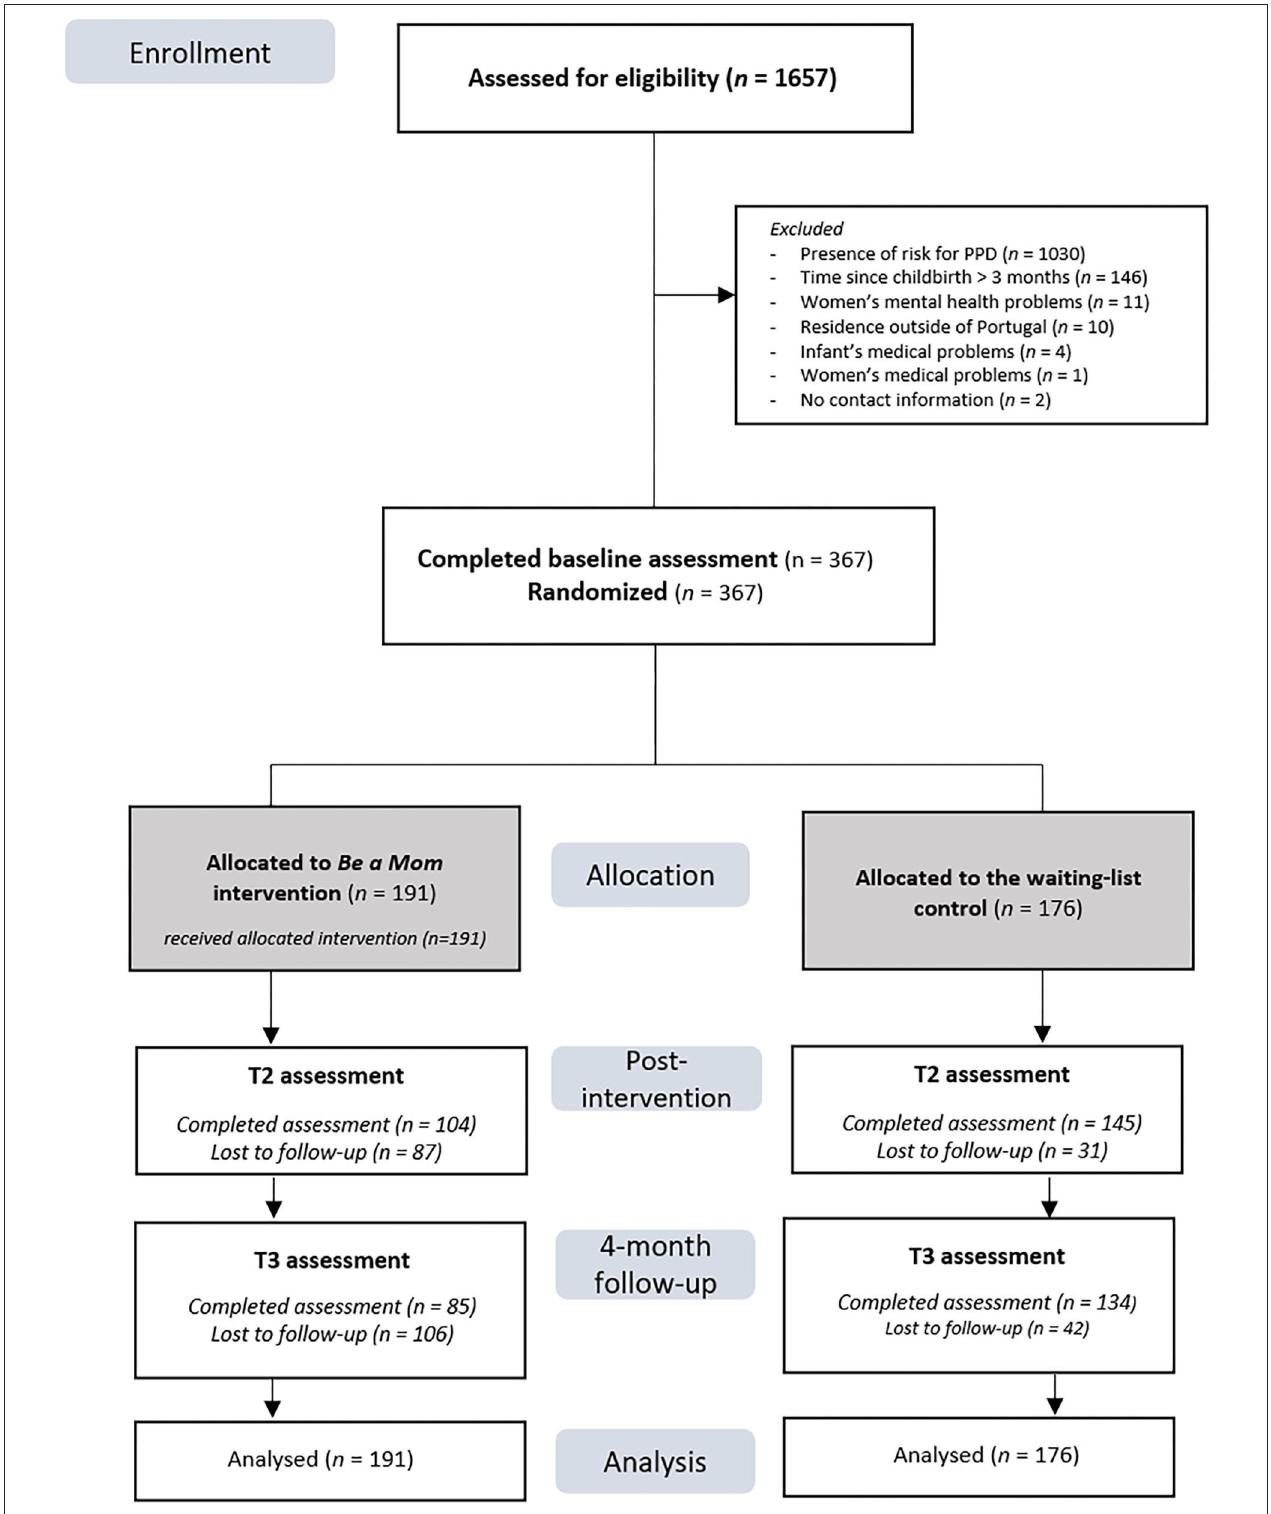
FIGURE 2 | Flowchart of the participants in the